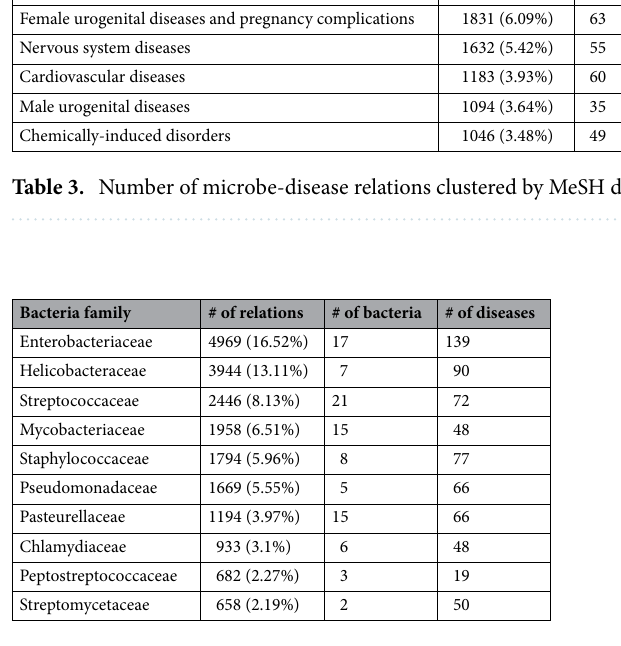
Table 4. Number of microbe-disease relations categorized by bacterial